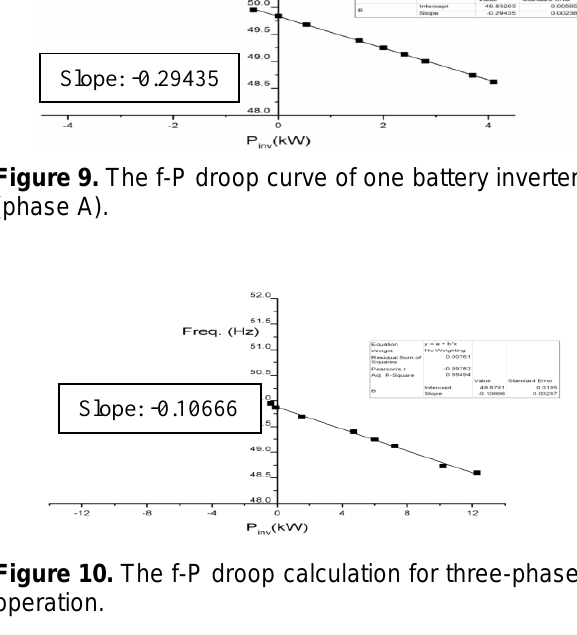
Figure 7. The measured f-P droop curve of the diesel genset for asymmetric loads.